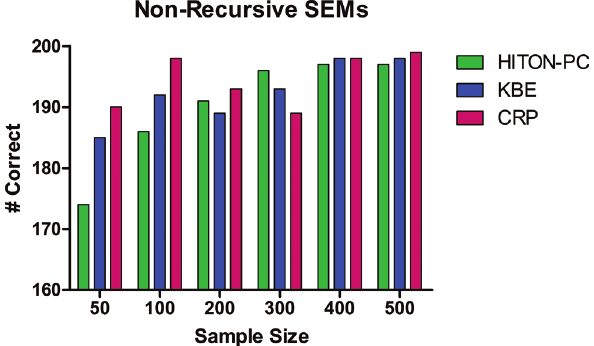
Figure 2: Same as Figure 1 except the 50 Markov boundaries were obtained from four linear Gaussian non-recursive SEM-IEs. The results are combined across the four SEM-IEs. CRP outperforms HITON-PC by a small margin in detecting a single variable within the Markov